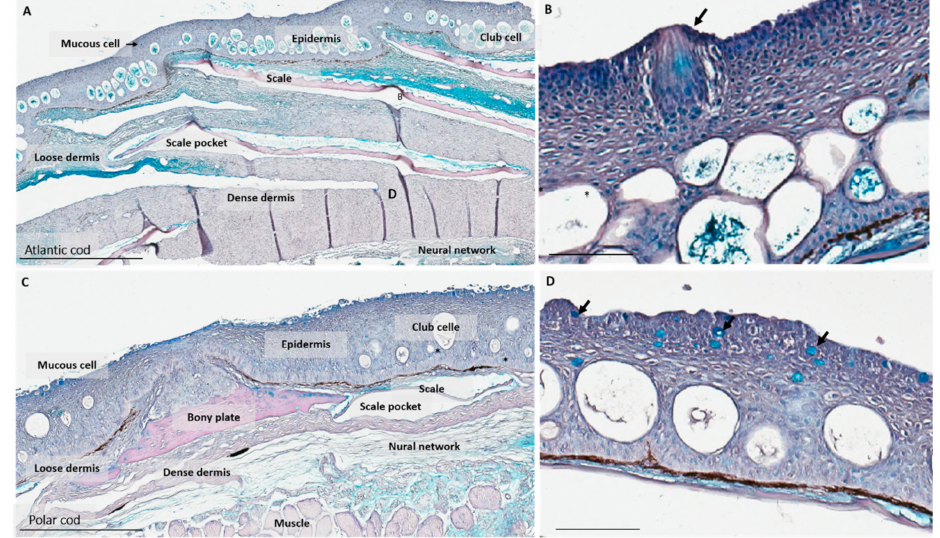
Figure 1. Alcian Blue / Periodic Acid - Schi ff (AB / PAS)-stained sections of skin from Atlantic cod and polar cod. ( A ) Atlantic cod showing the main components in fish skin: epidermis, scales, club cells, dense and loose dermis. Scales extend into the epidermal layers. ( B ) Enlarged image of epidermis showing a sensory cell (arrow). ( C ) Polar cod skin di ff ers from the Atlantic cod skin in that it has bony plates. Scales do not extend into the epidermis. ( D ) Enlarged image of polar cod epidermis, showing more mucous cells (arrows) compared to Atlantic cod. Scale bar = 500 µ m ( A , C ) and 100 µ m ( B , D ).